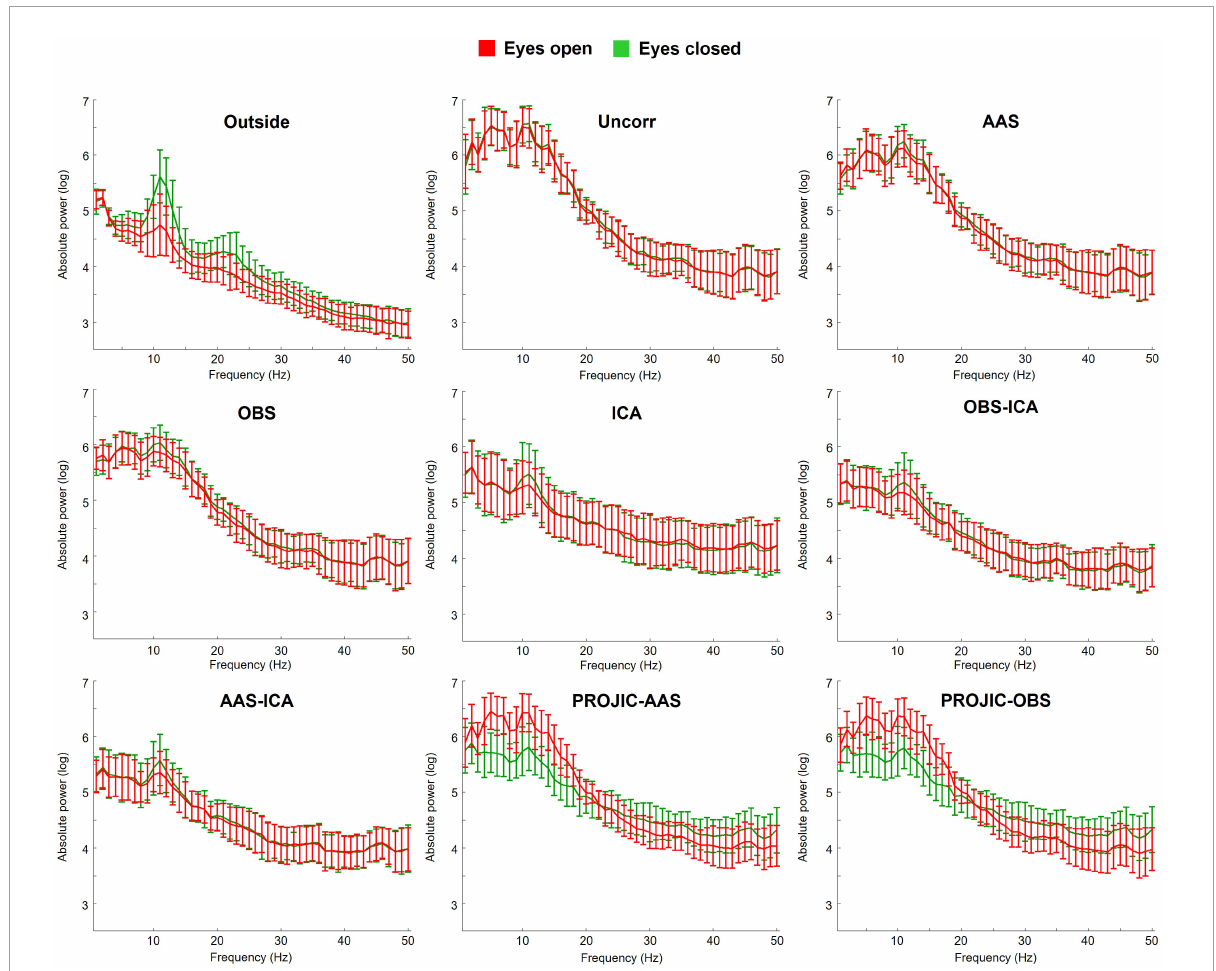
FIGURE5 Group average power spectrum (with standard deviation) of the O1 electrode during the eyes-closed (EC; green) and eyes-open (EO; red) conditions of the EC-EO task. A comparison is shown between the spectra obtained from the Outside EEG EC-EO and the EEG-fMRI EC-EO data, before and after removing the BCG artifact with each correction method. ICA-based approaches performed better in retrieving the difference between EC and EO conditions (reflected as higher alpha power for the EC condition), though the difference was still attenuated when compared to the data acquired outside the